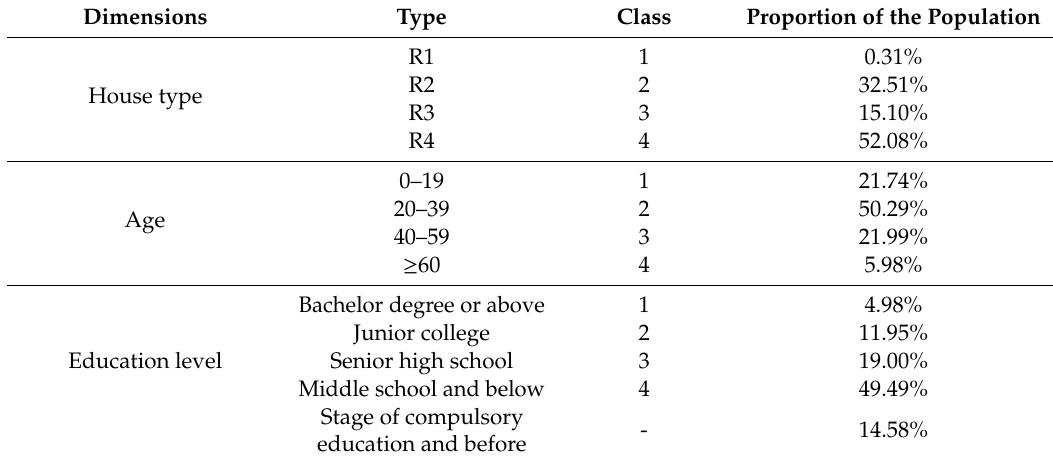
Table 1. The classification of residents and the proportion of di ff erent